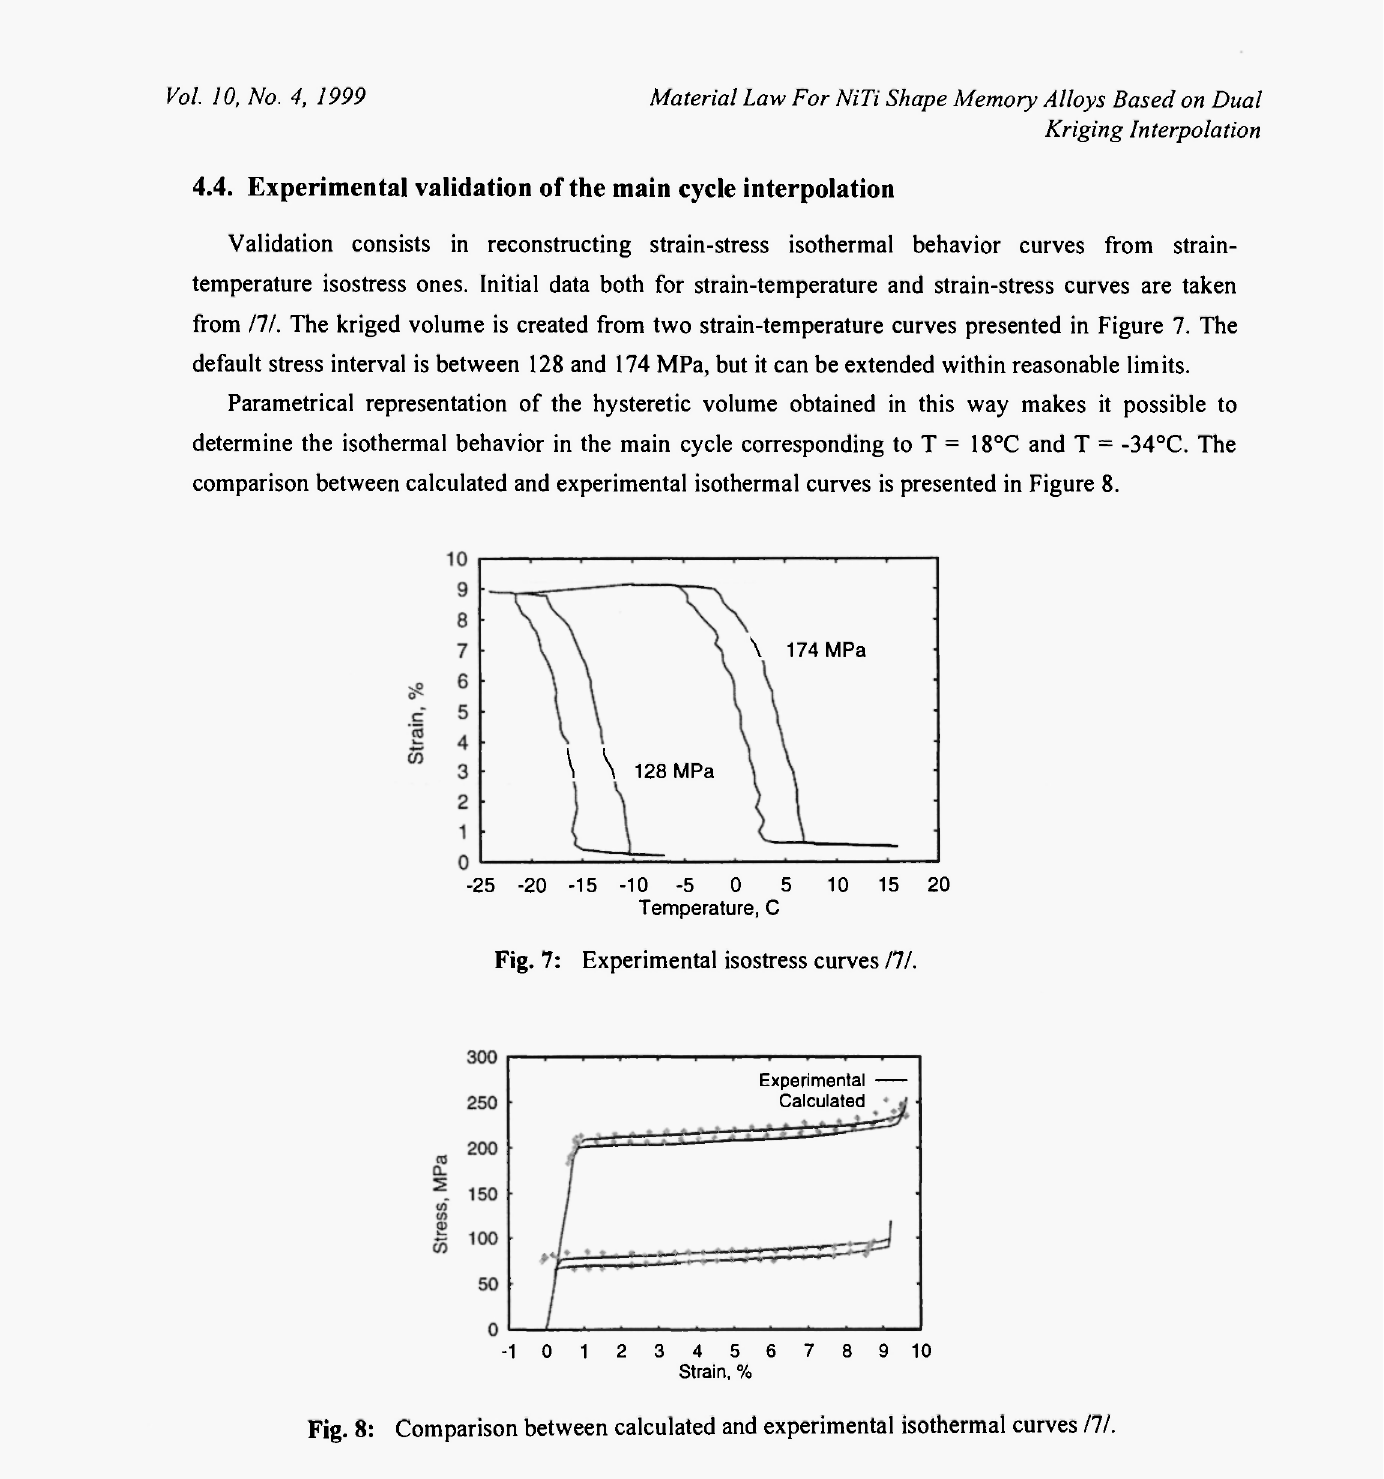
Fig. 8: Comparison between calculated and experimental isothermal curves